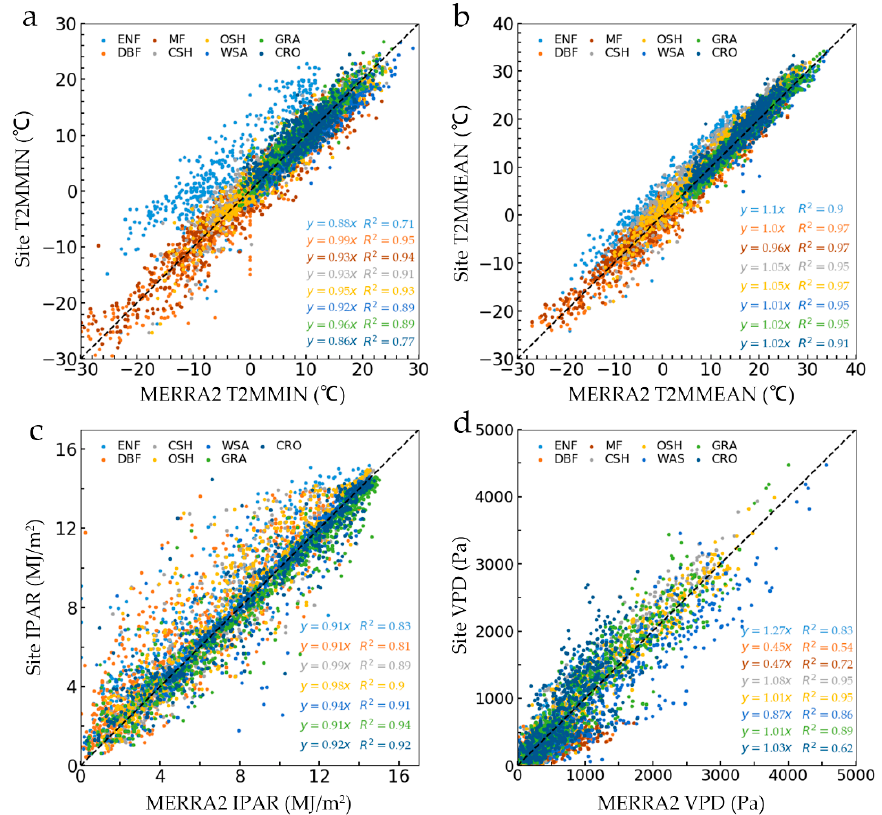
Figure 2. Scatter plots of daily Modern-Era Retrospective analysis for Research and Applications (MERRA2) meteorology reanalysis data against daily site meteorology data: ( a ) T2M_MIN; ( b ) T2M_MEAN; ( c ) IPAR; and ( d ) VPD from different biome types.